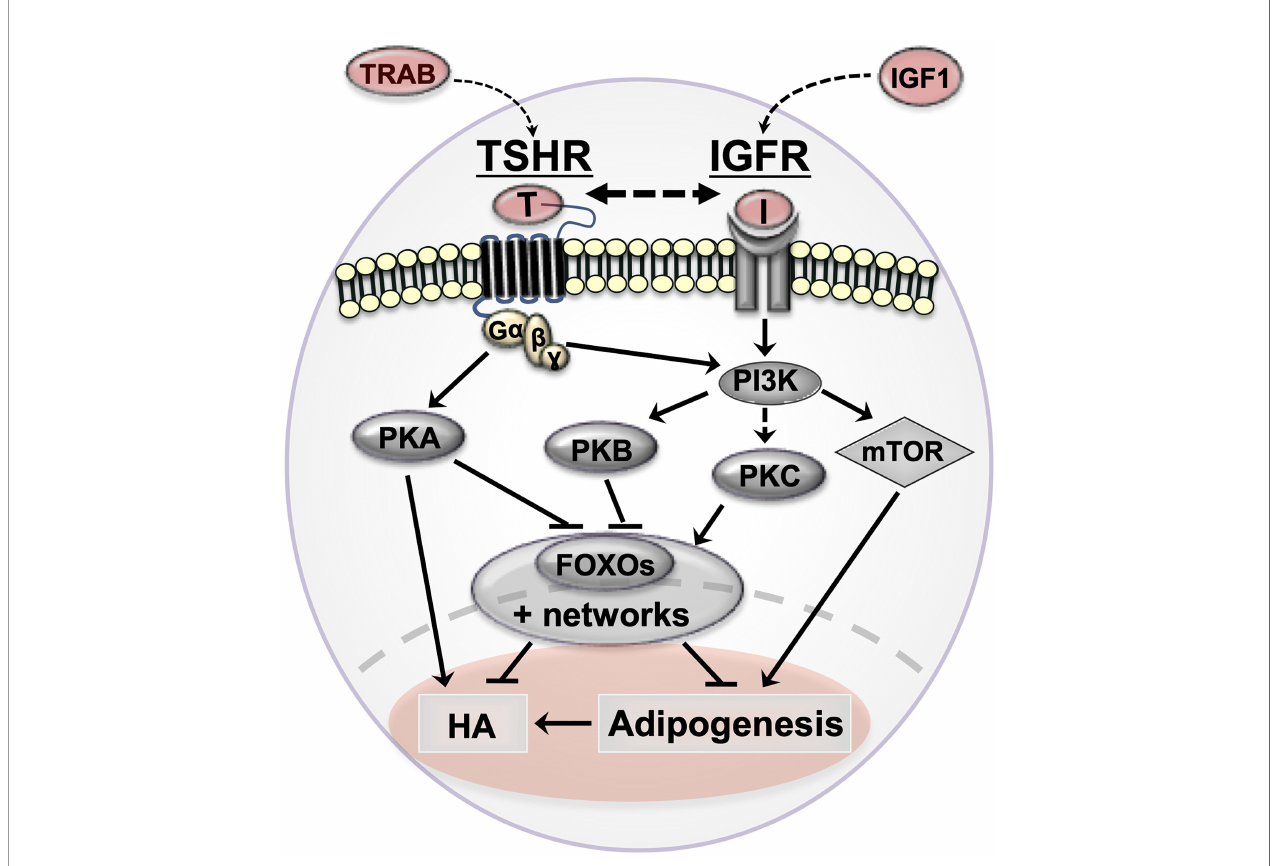
FIGURE 1 | Cartoon summarizing orbital fi broblast signaling cascades in Graves ’ orbitopathy (GO) and how they affect pathogenetic mechanisms (adipogenesis and hyaluronan production). TSHR/TRAB and IGFR/IGF are shown in red with arrows indicating the possible crosstalk between the pathways in GO. thyrotropin receptor (TSHR, serpentine structure); TSHR auto-antibodies (TRAB); Insulin-like growth factor 1 receptor (IGF-1R) and IGF1; protein kinase A (PKA); protein kinase B (PKB/ Akt); protein kinase C (PKC); phosphoinositide 3-kinase (PI3K); forkhead box protein O (FOXO); hyaluronan production